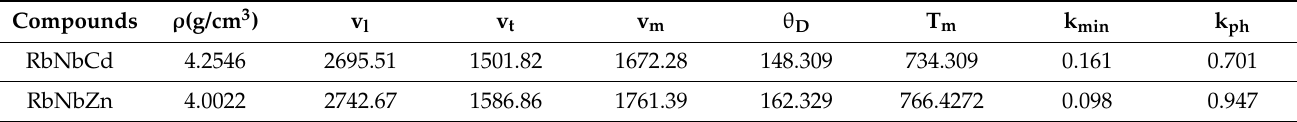
Table 4. Computed density, longitudinal, transverse, and average elastic wave velocity [ ρ (in g/cm 3 ), v l , v t , v m (in m/s)], the Debye temperatures ( θ D in K), Melting temrperature (T m in K), and minimum and lattice thermal conductivity at 300K (k min , k ph in